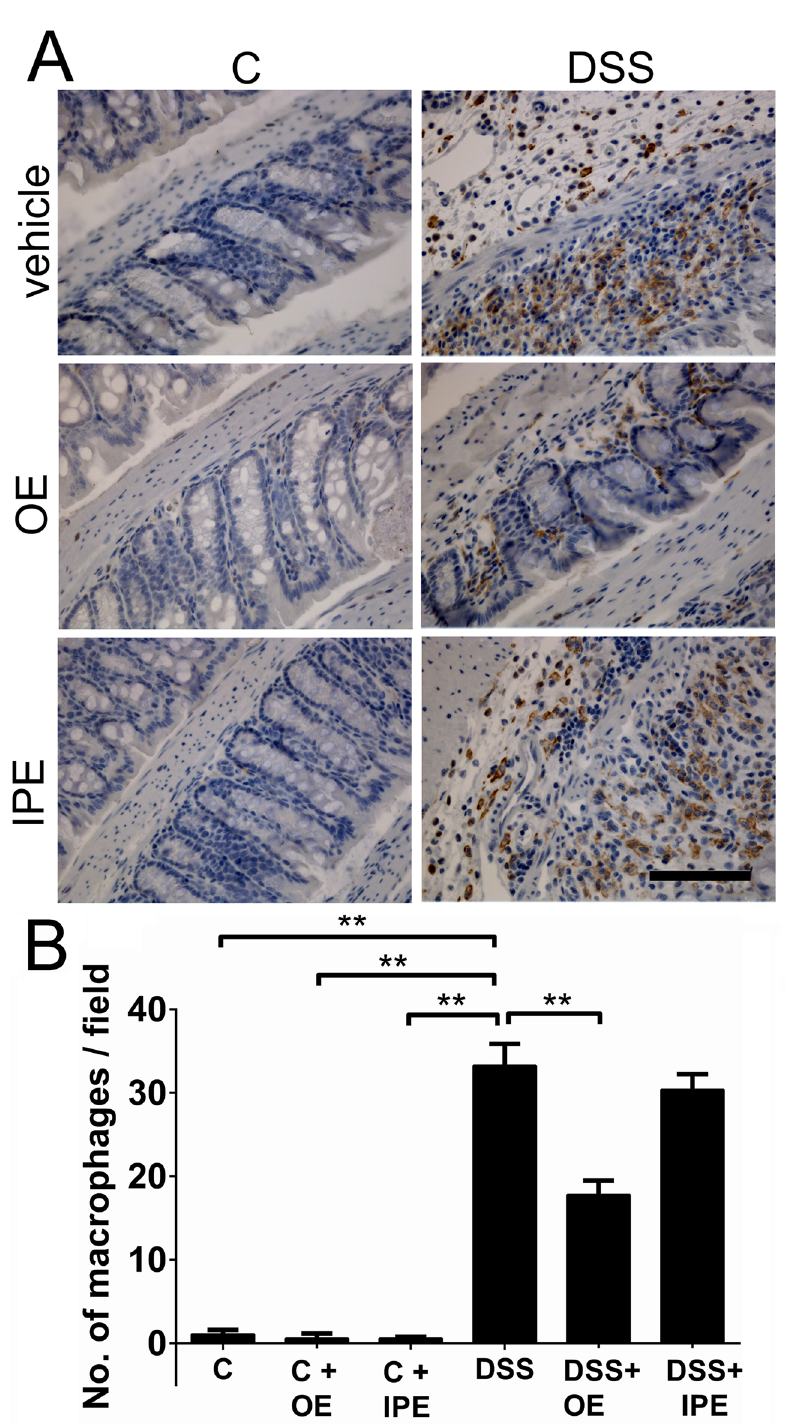
Fig 7. Effect of enoxaparin on macrophage infiltration into the inflamed colon. (A) Representative immunostaining of F4/80-positive macrophages in in the distal colon from healthy and colitic mice treated with and without enoxaparin. (B) Quantification of macrophages (F4/80 + cells) in the colons. Results are expressed as mean ± SD of ten representative high-power fields per tissue section of 3 – 5 mice each. ** p < 0.01. Scale bar = 100 μ m for 400 × magnification. Control, C; untreated colitis, DSS; oral enoxaparin, OE; intraperitoneal injection of enoxaparin, IPE.